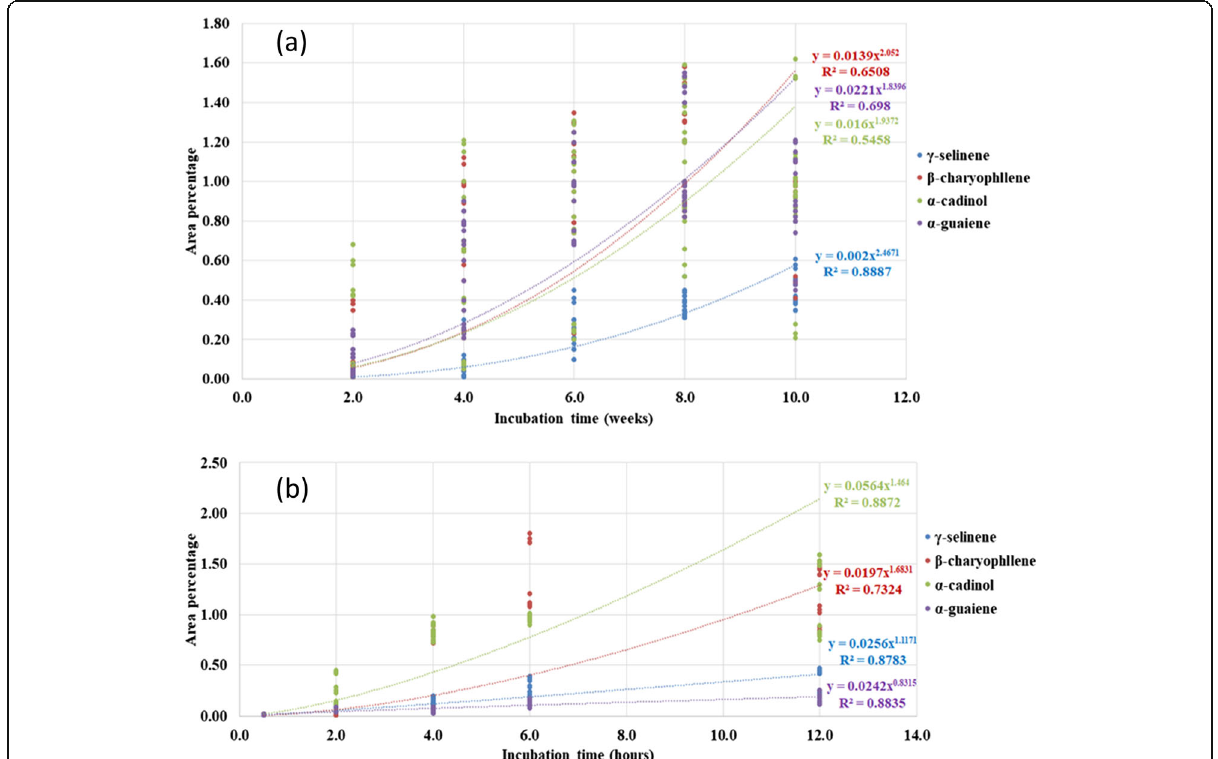
Fig. 13 Trends of area percentages of biologically elicited ( a ) G. walla calli and ( b ) cell suspension. The graphs include the data up to the maximum area percentage of